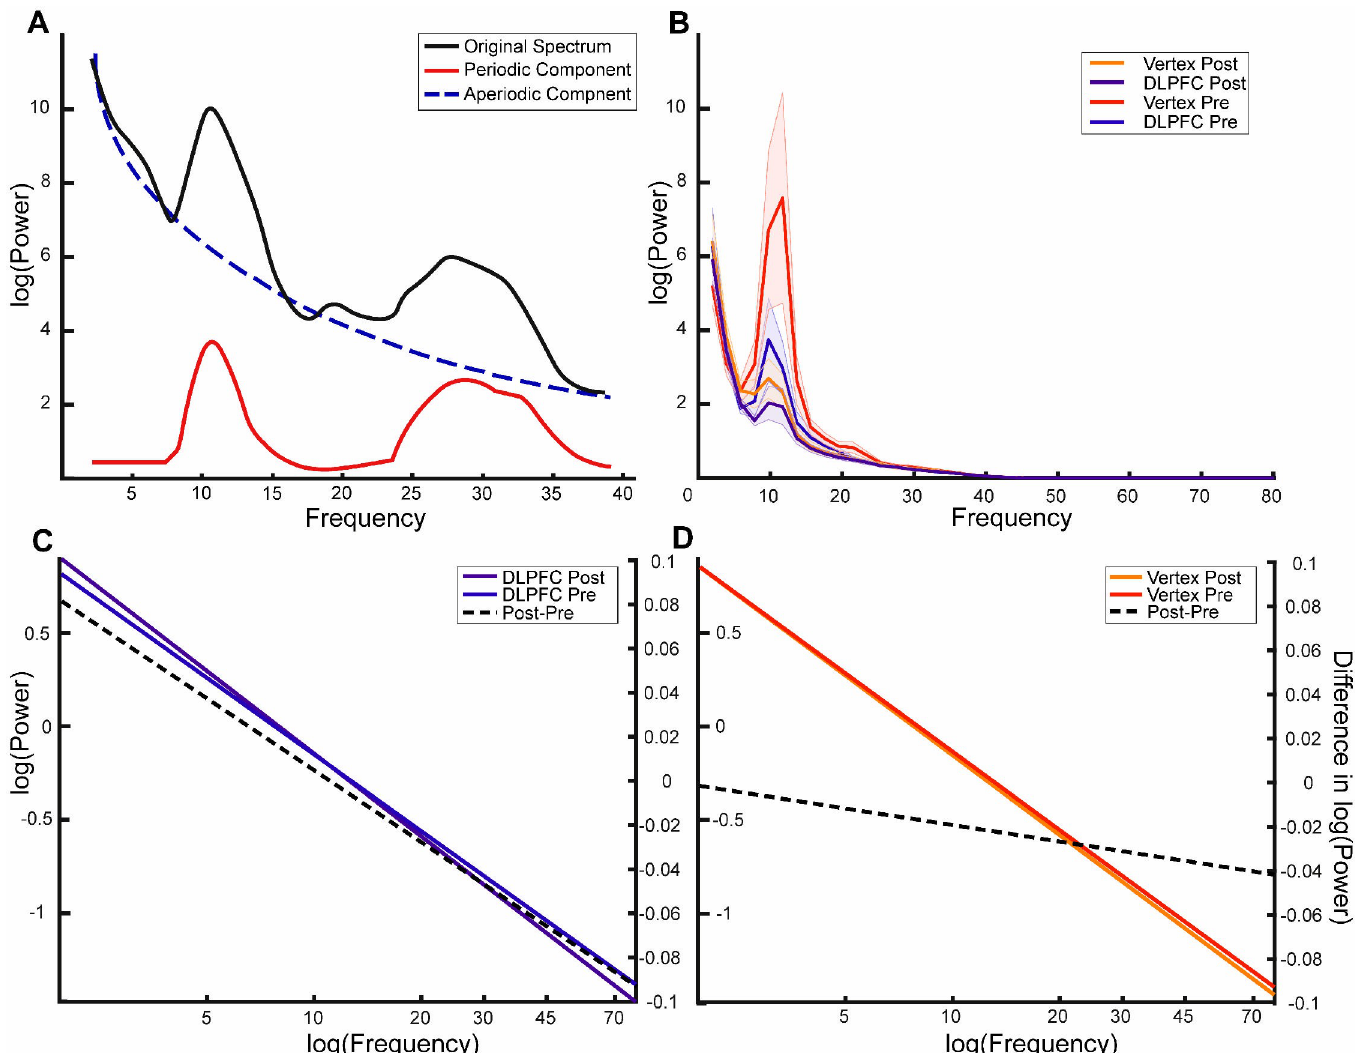
Fig 4. FOOOF analysis shows that beta effects are nonoscillatory in nature. (A) Schematic representation of the different components in a given power spectrum. The black line represents a typical power spectrum that is to be separated. The blue line is the corresponding log function following removal of the periodic peaks, thereby representing aperiodic properties of the signal. (B) Power spectra separated by each condition. Shaded area indicates standard error. (C, D) Line plots of the mean aperiodic component before and after item presentation for the DLPFC and vertex condition, respectively. The right axis relates to the plotted post–pre difference (dotted line). The x-axis has been extended for illustrative purposes to highlight the differences in slopes between the difference conditions. The actual fit was performed on data in the 1–40 Hz range. The data and scripts used to generate this figure can be found at https://osf.io/dyxjv/. DLPFC, dorsolateral prefrontal cortex.